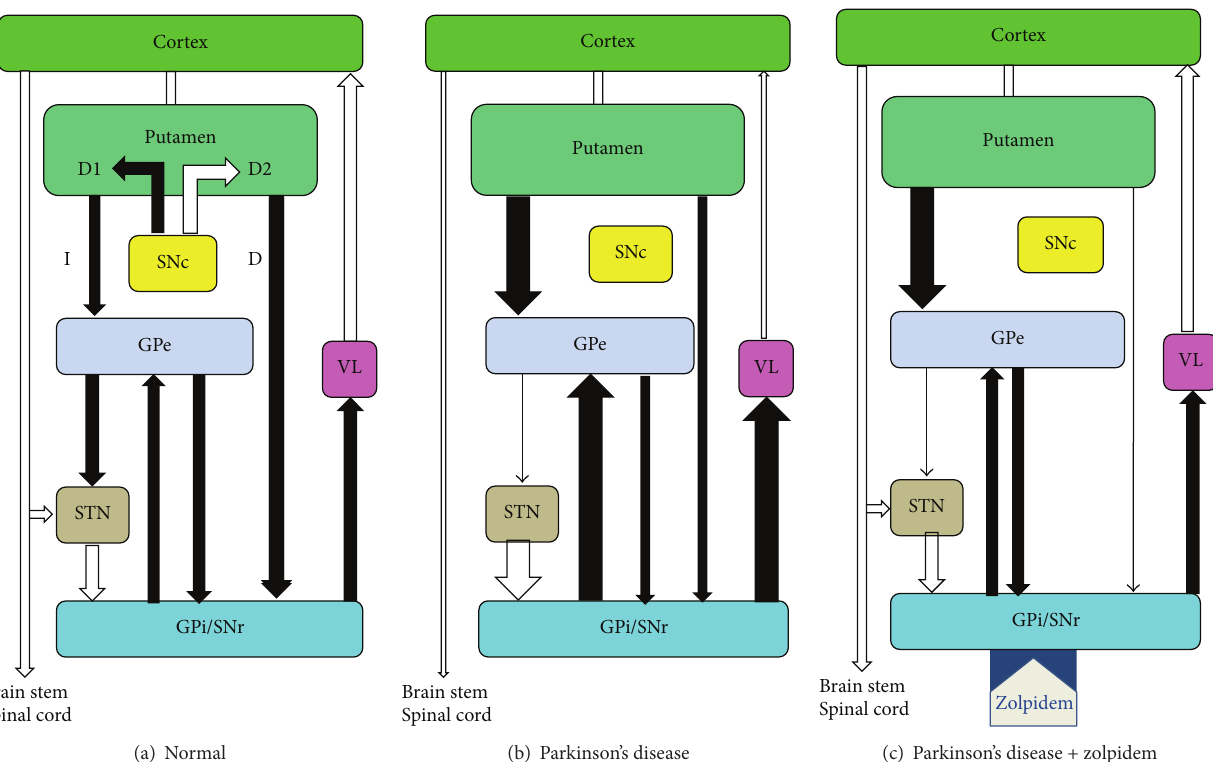
Figure 1: Schematic representations of the activity of the cortical-basal ganglia loops, showing the direct (D) and indirect (I) circuits in normal subjects (a), patients with Parkinson’s disease/Parkinsonism (b), and patients with Parkinson’s disease treated with zolpidem (c). In PD [18], zolpidem may induce, through GABA A receptors containing the 𝛼 1 subunit, a selective inhibition of the GPi and the SNr (the two main inhibitory GABAergic output structures of the basal ganglia), which are overactive in PD (b) and show binding sites for zolpidem (c). The inhibition of the GPi and the SNr directly induced by zolpidem may result in an increased activity of some motor cortical areas (such as supplementary motor area), which may underlie the possible improvement of Parkinsonian motor symptoms which can be observed after the administration of zolpidem. Although binding sites for zolpidem in the STN are not displayed in (c), the STN was found to have binding sites forzolpidem[36]andmightbereasonablyconsideredanadditionaltargetforzolpideminPDpatients.InPD,zolpidemmightinhibittheSTN as well, giving rise to decreased excitatory inputs from the STN to the GPi and SNr, resulting in a further mechanism leading to a decreased activity of the GPi and SNr, indirectly induced by zolpidem through its inhibition of the STN. White arrows = excitatory connections; black arrows = inhibitory